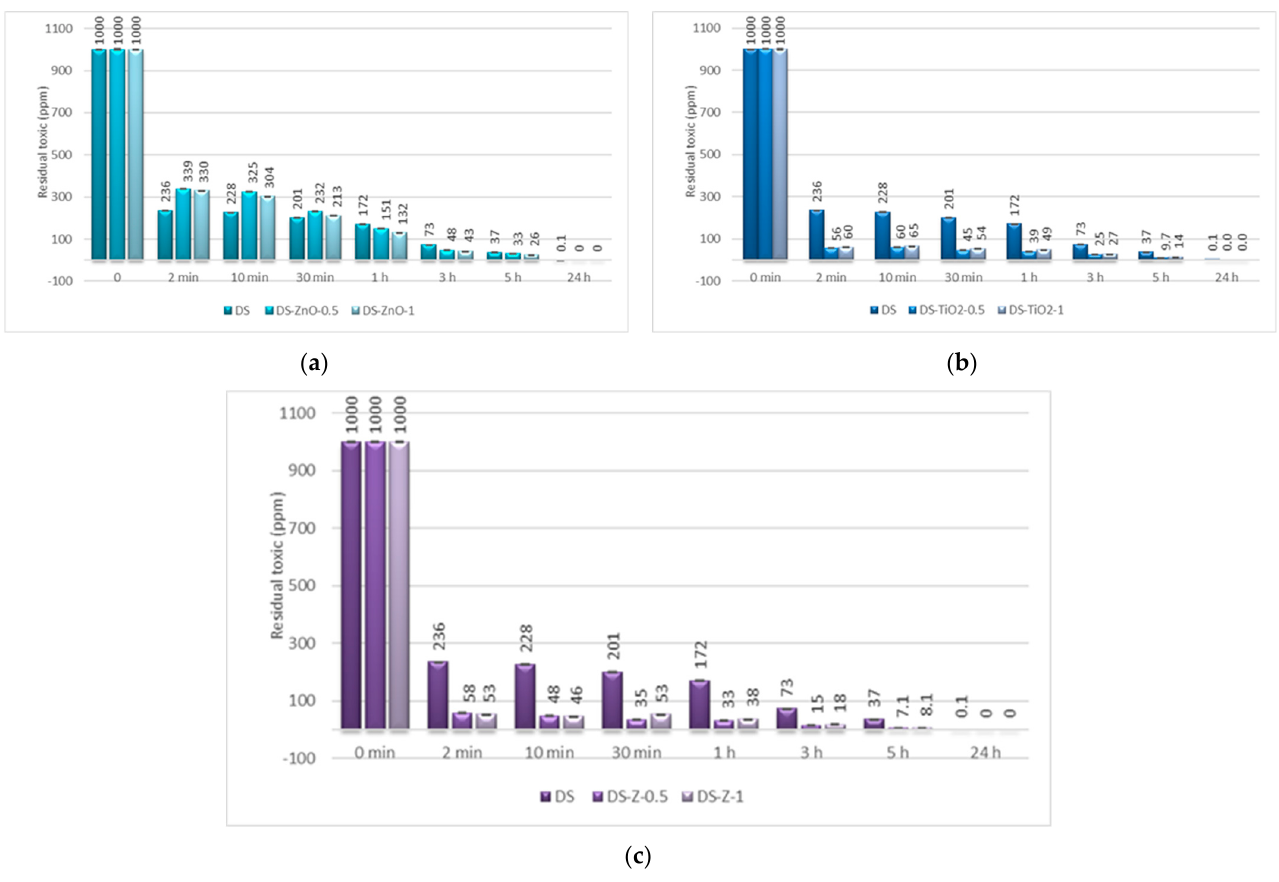
Figure 10. Residual sulfur mustard after employing decontamination formulations based on ( a ) ZnO, ( b ) TiO 2 , and ( c ) zeolite (detailed statistical data presented in Tables S9 and S10—Supplementary Material File).